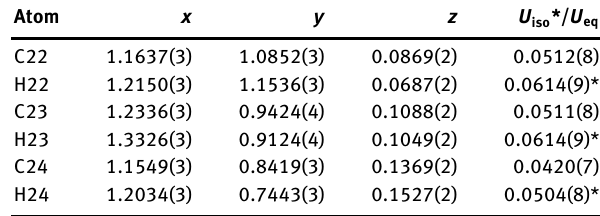
Table 2: Fractional atomic coordinates and isotropic or equivalent isotropic displacement parameters (Å 2